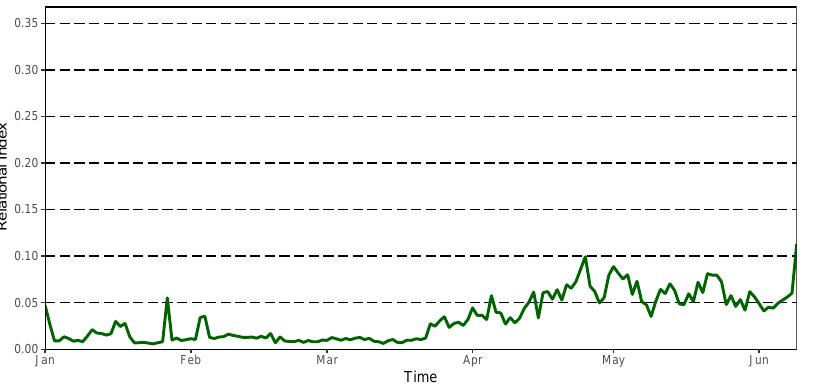
Figure 6. Community relational index ( RI ) trend during COVID-19 lockdown (January–June